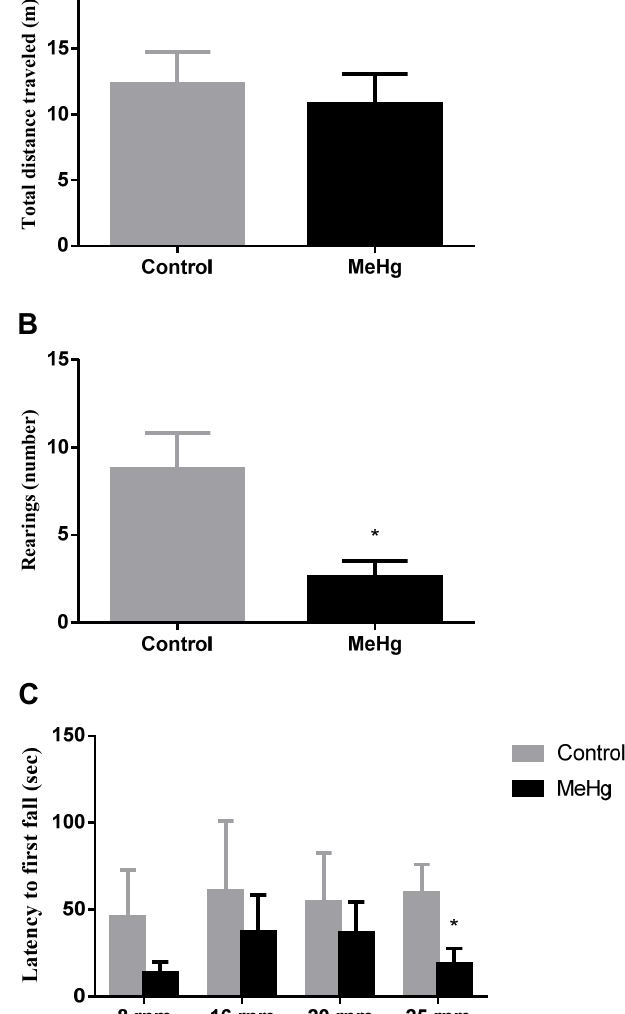
Figure 1. Effects of methylmercury (MeHg) in motor performance. Total distance walked ( A ) and number of rearings ( B ) registered in the open field test, and latency time to the first fall in the rotarod test ( C ) were analyzed in rats orally exposed to water (Control) or MeHg 5 mg/kg (MeHg) for four consecutive days. Behavioral tests were performed 24 h after the last dose of treatment. Results are expressed as mean ± SEM. n = 4–5 per group. Student t test, * p < 0.05 vs. control.